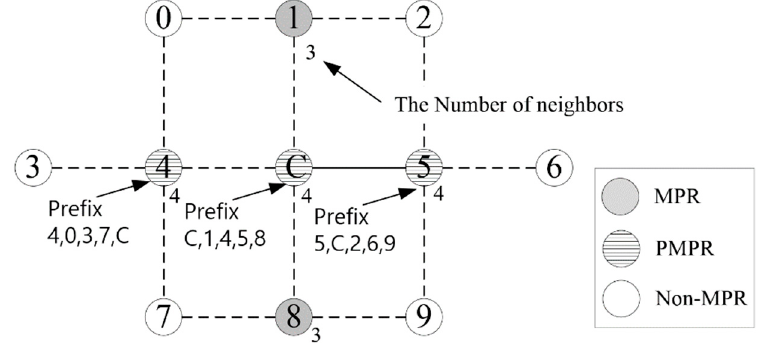
Figure 6. An example of Publisher MPR (PMPR) selection and aggregated prefix information of the multi-hop Content-prefix Announcement (CA) in TOP-CCN.